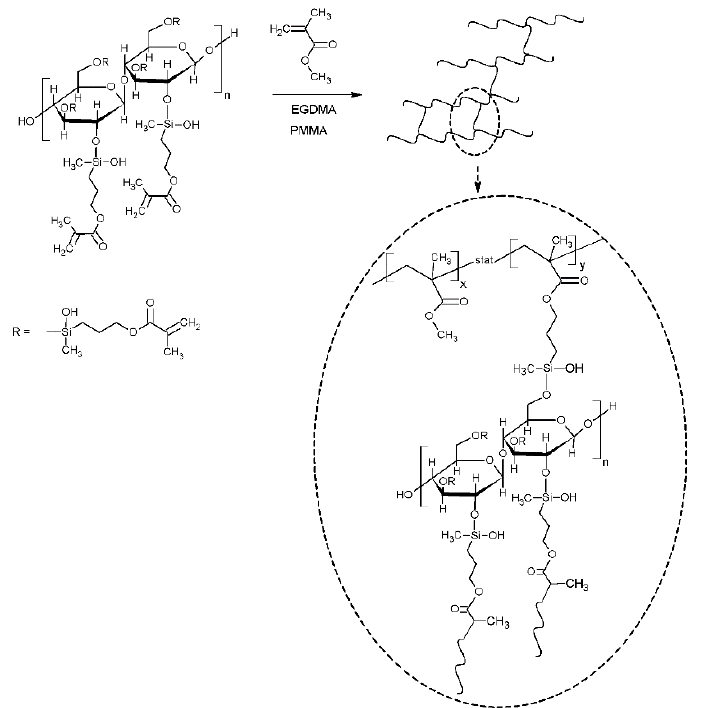
Figure 2. Scheme demonstrating the incorporation of modified cellulose into poly(methyl methacrylate) (PMMA) matrix.